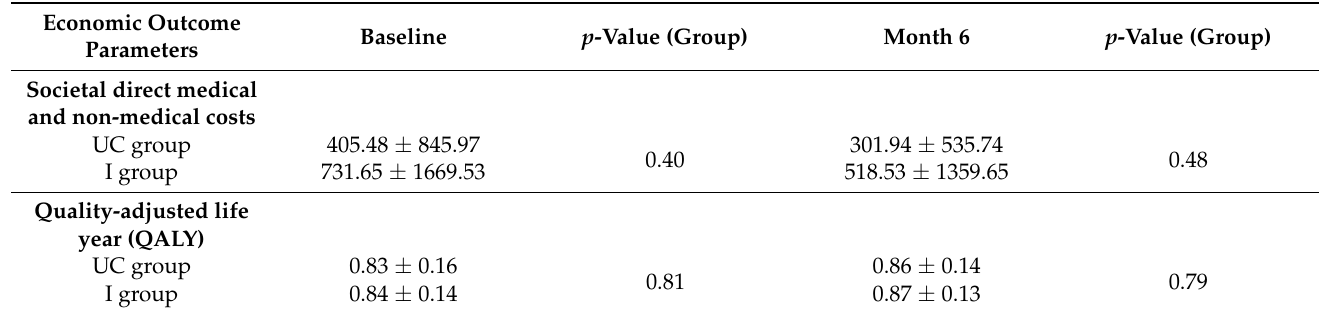
Table 2. Change in direct costs and QALY (mean EUR ± SD).